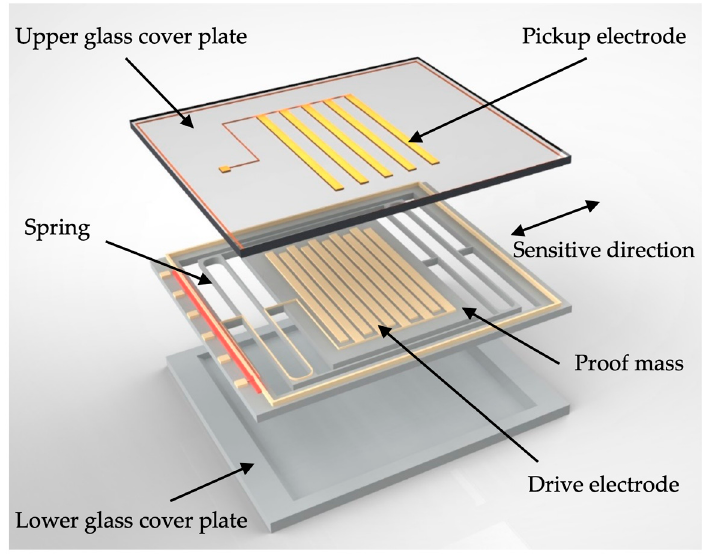
Figure 1. Schematic of the proposed MEMS accelerometer.